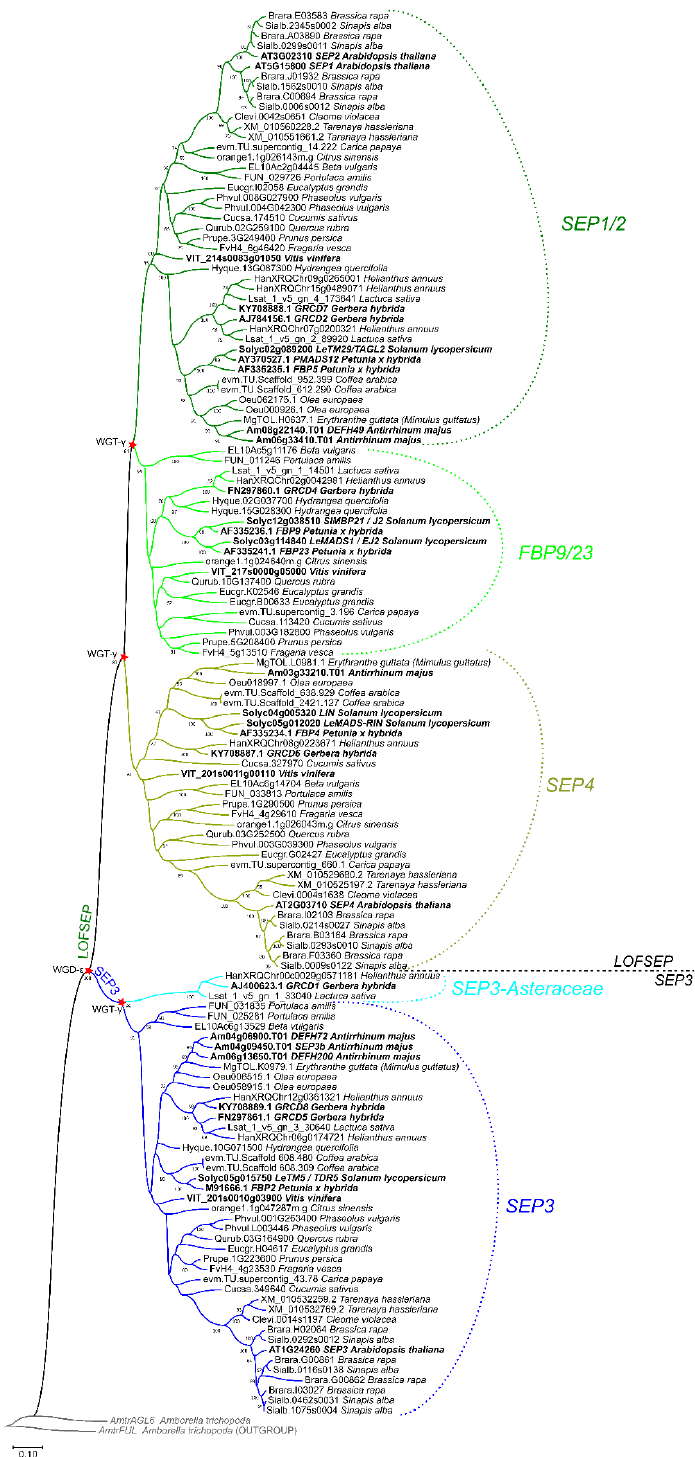
Figure 4. ML phylogenetic analysis of the SEPALLATA ( SEP ) subfamily genes in core eudicots. Dichotomies unequivocally linked to the angiosperm WGD- ε and the core eudicot WGT- γ events are marked with a red star. The three LOFSEP subclades of core eudicots, SEP1/2 , FBP9/23 and SEP4 , are marked with different shades of green. The main SEP3 subclade and the Asteraceae-specific SEP3 clade are marked with different shades of